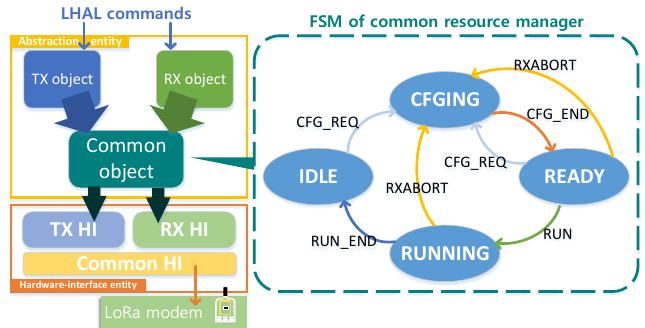
Figure 3. The inner mechanism of the